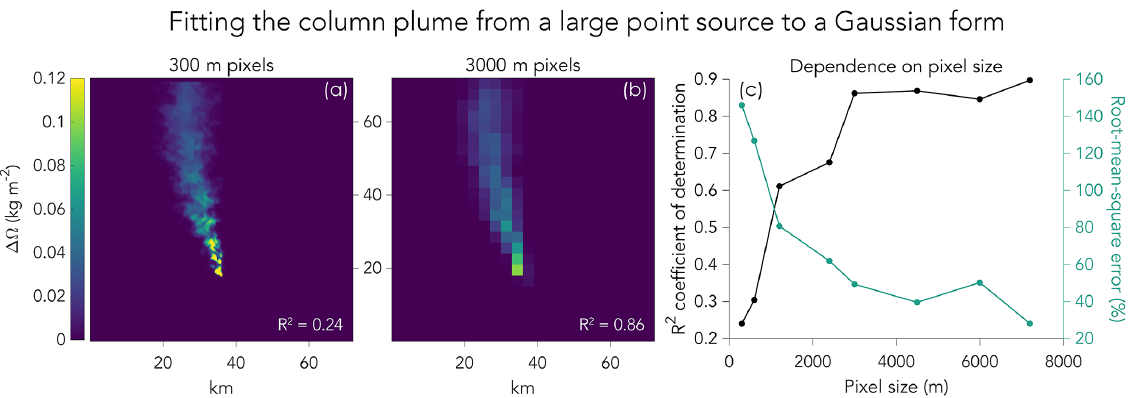
Figure 2. CO 2 column enhancements relative to background for a 3.75ktCO 2 h − 1 (33MtCO 2 a − 1 ) power plant plume simulated by LES at 300m resolution. (a) shows the plume with 300m pixel resolution and (b) shows the same plume but with pixel resolution degraded to 3000m. The coefficient of determination ( R 2 ) inset measures the ability to fit each LES plume to a Gaussian form (Eqs. 2–3). (c) shows how the coefficient of determination and the root-mean-square error (expressed as a percentage of the median pixel enhancement) vary with pixel